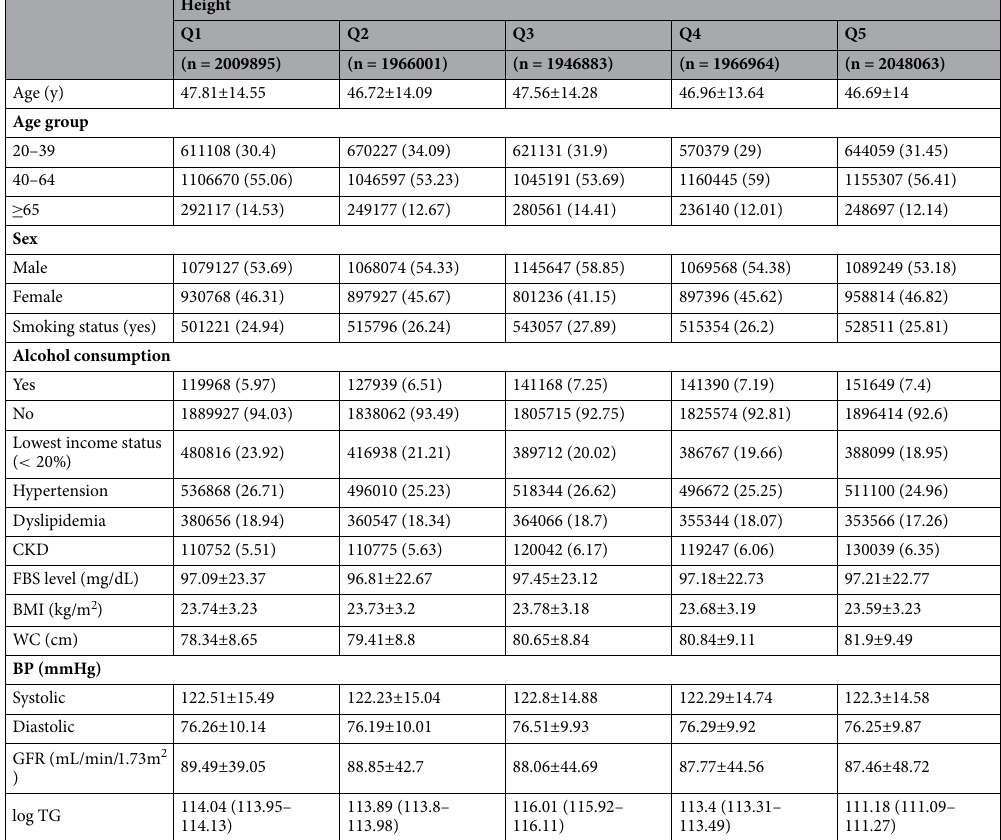
Table 1. Demographics of subjects according to height quintile. CKD chronic kidney disease, FBS fasting blood sugar, BMI body mass index, WC waist circumference, BP blood pressure, GFR glomerular filtration rate, TG triglyceride. Data are expressed as mean ± SD or n